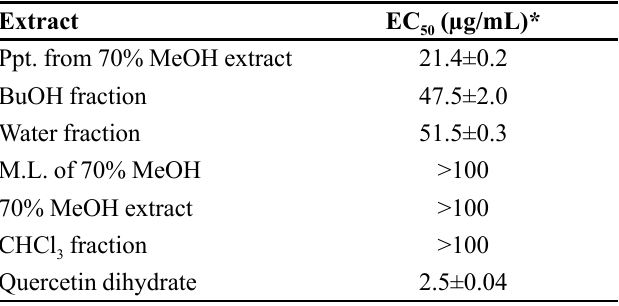
Quercetin dihydrate 2.5±0.04 *Data are means ±S.E of three